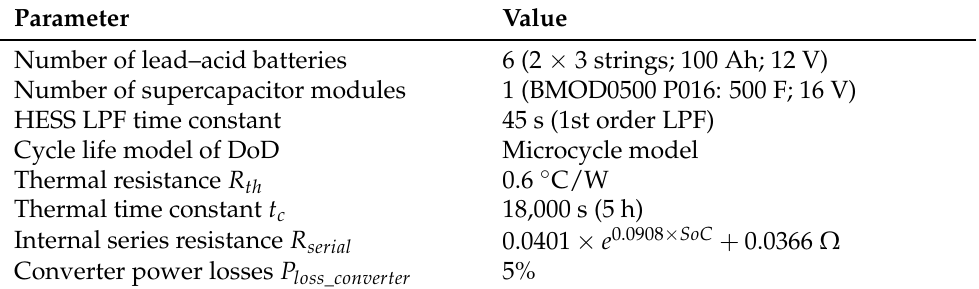
Table 3. Default HESS